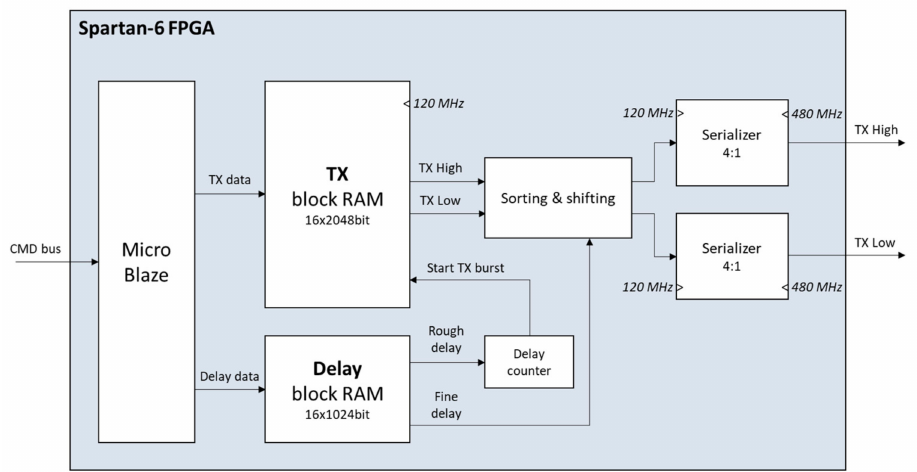
Figure 4. Simplified design of the front-end TX